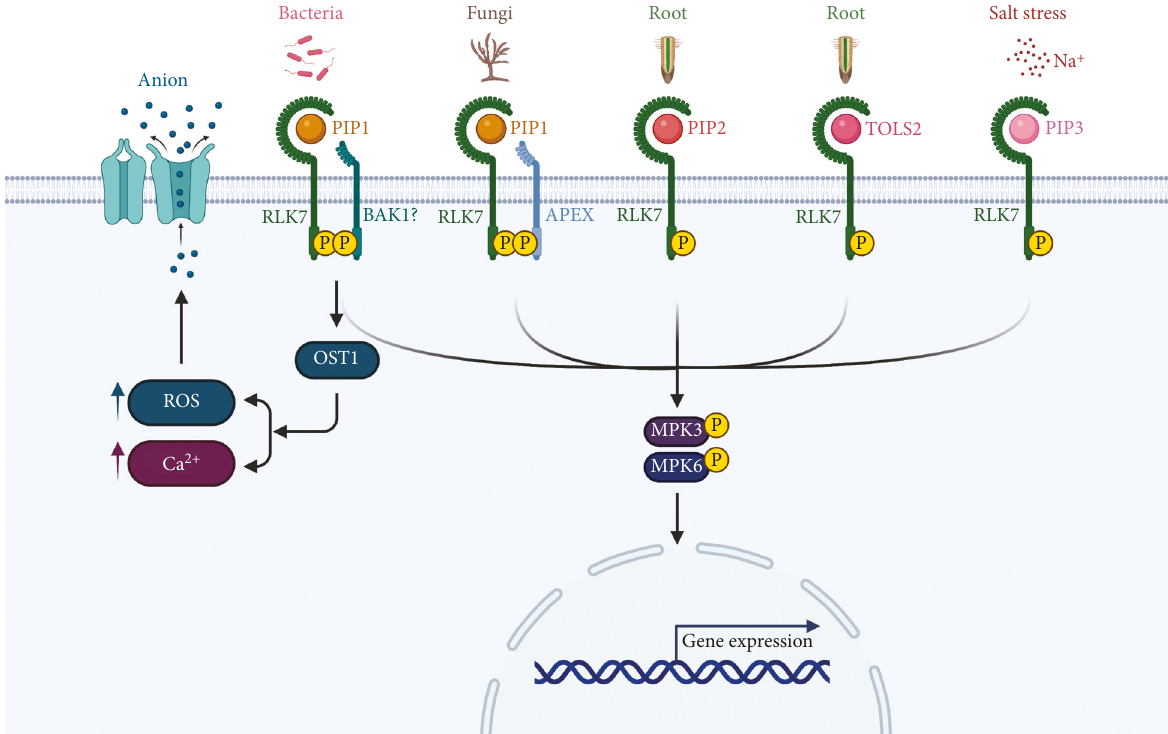
Figure 4: Interaction of RLK7 with peptides. Upon sensing bacteria, RLK7 interacts with PIP1 and triggers a downstream signal. While BAK1 may interact with the PIP1-RLK7 complex, both are phosphorylated, OSTI increases ROS production, and Ca 2+ ion carriers activate the SLAC1 channel and close the stomata. RLK7-PIP1 may also interact with APEX upon detection of fungal chitin. Moreover, RLK7 can also interact with either PIP2 or TOLS2 to control lateral root initiation. Furthermore, RLK7 interacts with PIP3 and induces salt tolerance in the presence of salt. MPK3/MPK6 is phosphorylated to initiate the respective gene expressions in all